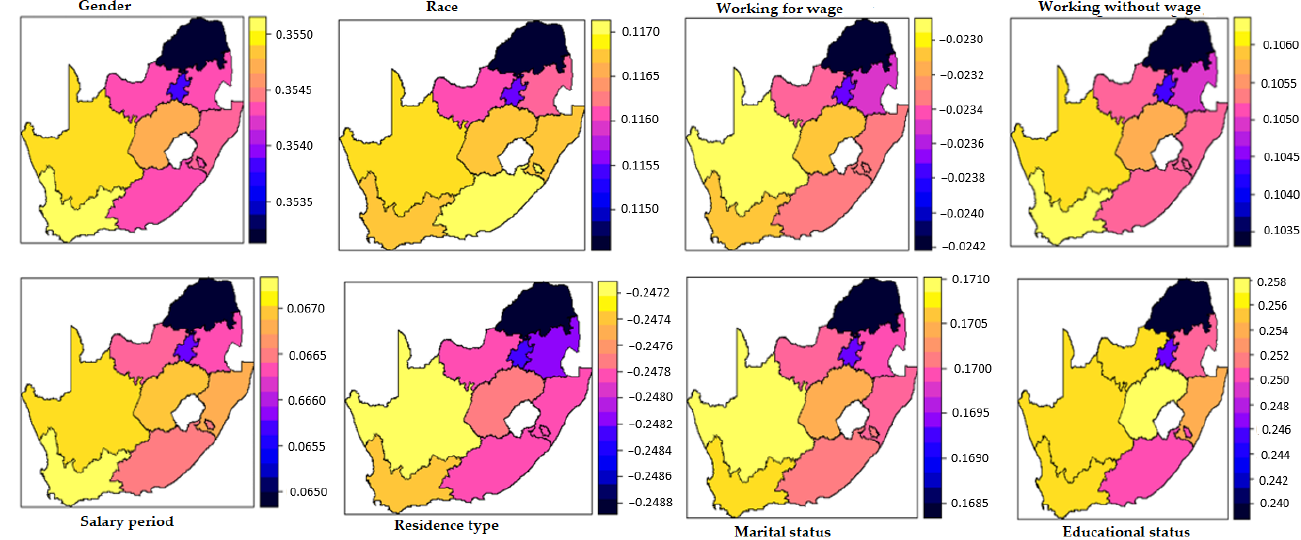
Figure 2. Spatially varying effects of covariates on diabetes.